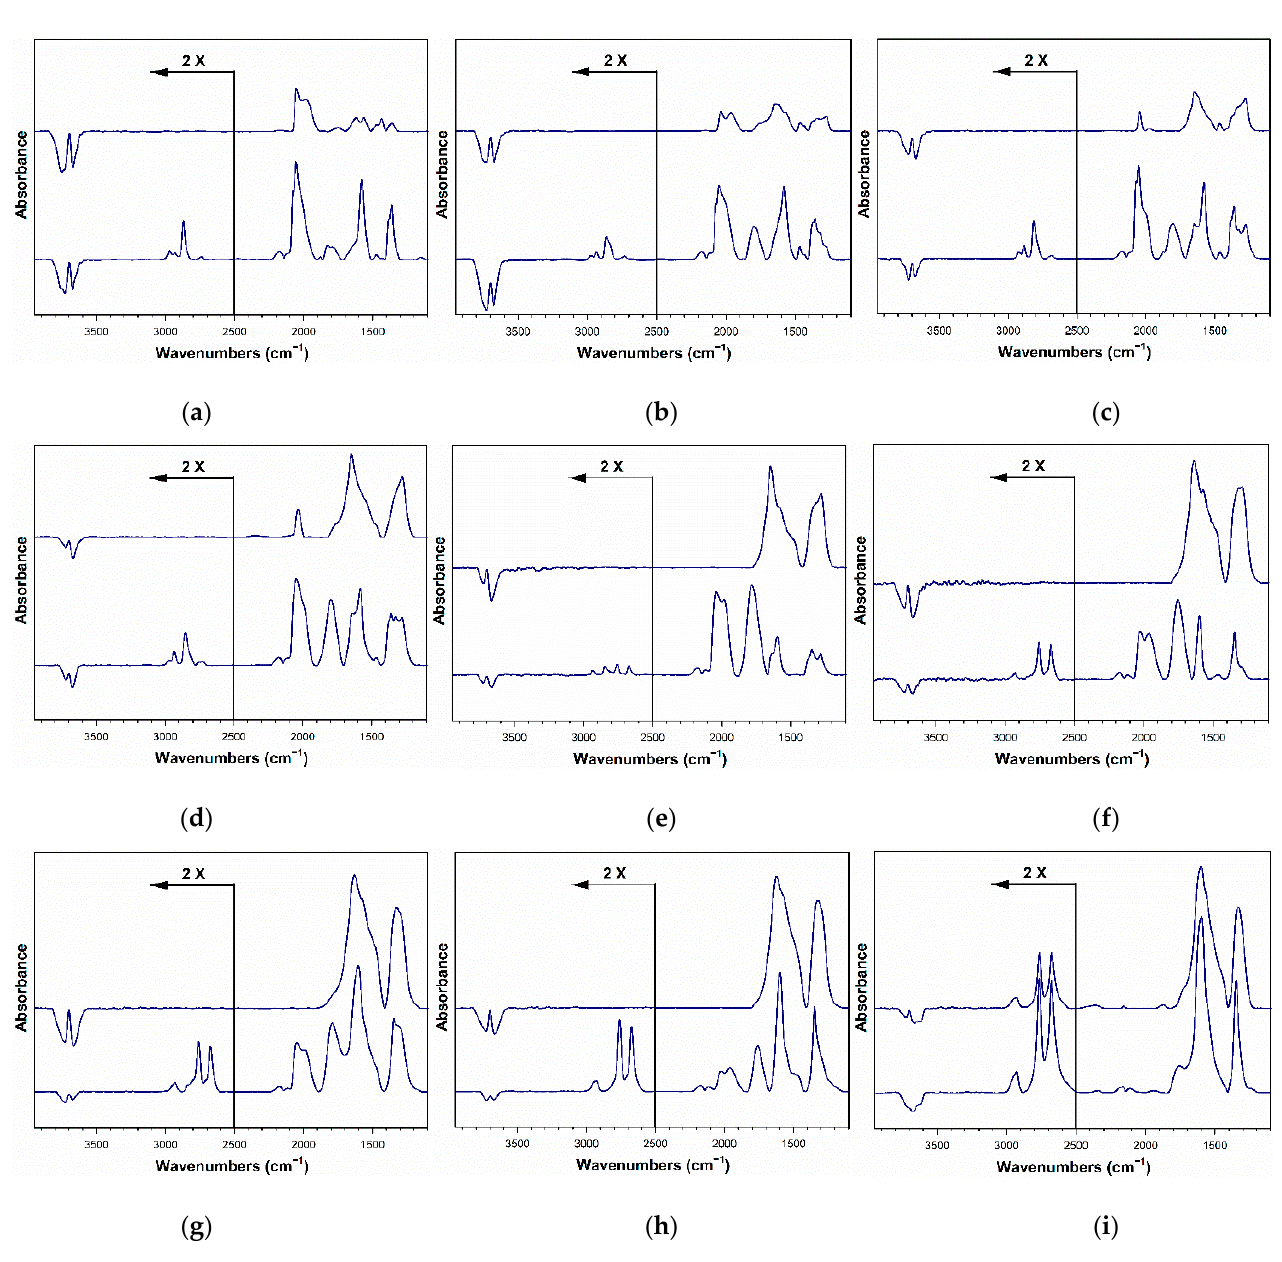
Figure 18. DRIFTS spectra taken ( bottom ) before and ( top ) after formate decomposition in steam for ~100 min, including ( a ) 2%Pt/ZrO 2 , and the same catalyst with ( b ) 0.55%Rb, ( c ) 0.93%Rb, ( d ) 1.86%Rb, ( e ) 2.79%Rb, ( f ) 3.72%Rb, ( g ) 4.65%Rb, ( h ) 5.58%Rb, and ( i ) 9.29%Rb.